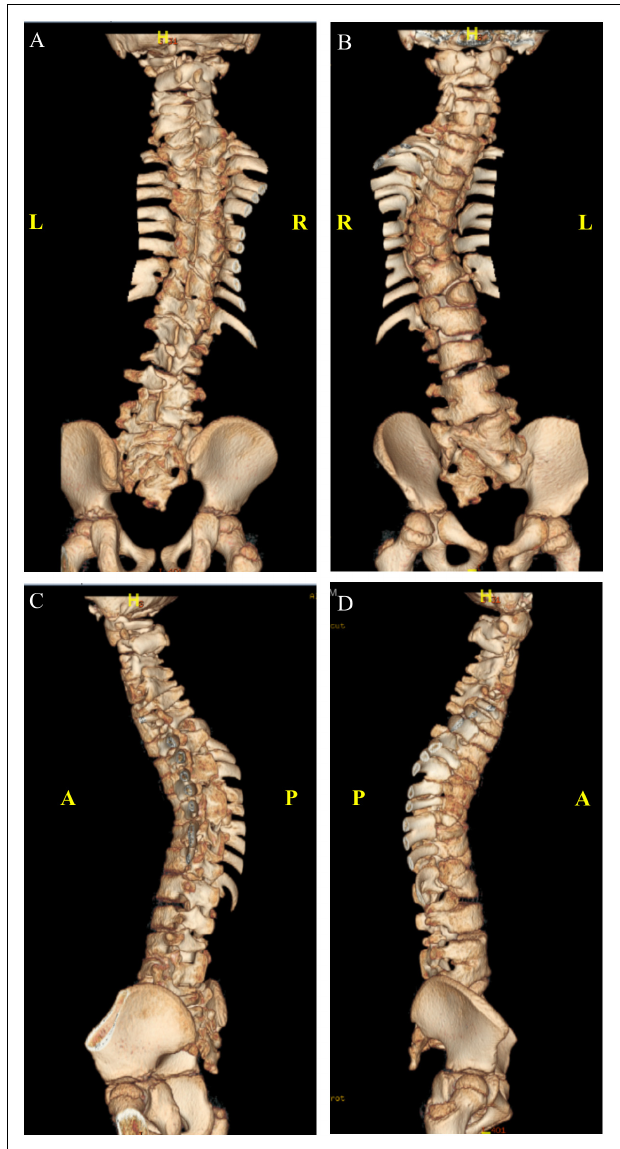
FIGURE 3 | Three-dimensional computed tomography (CT) scan. (A) Anterior. (B) Posterior. (C) Left lateral. (D) Right lateral view.